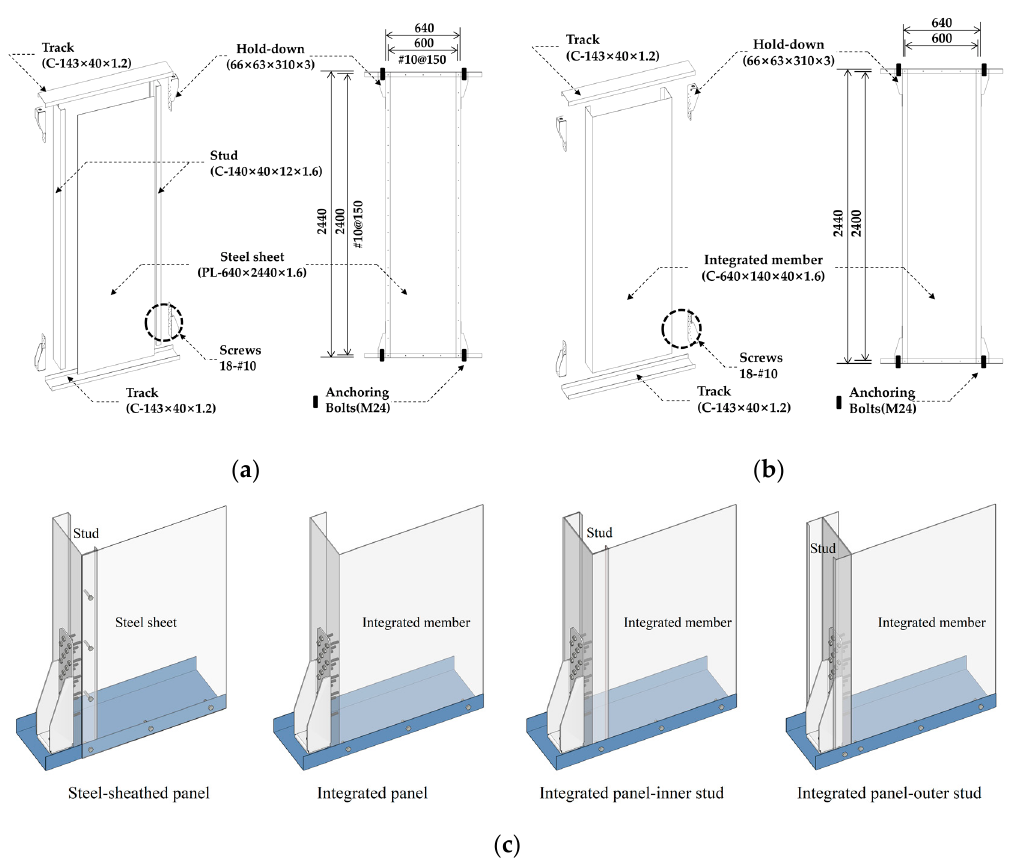
Figure 4. Configurations and details (mm): ( a ) Steel-sheathed panel, ( b ) Integrated panel, ( c ) Lower left side of the specimens. Note that the specifications of the integrated panel-stud specimens are identical except for the addition of reinforcing studs.